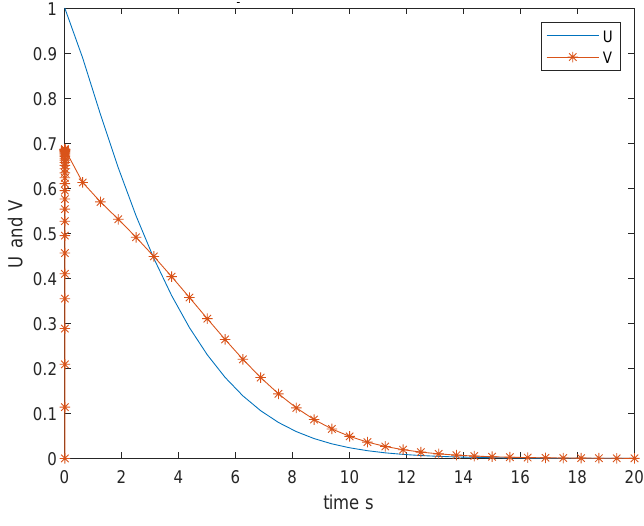
Figure 1. The numerical solution U, V on the interval [0,